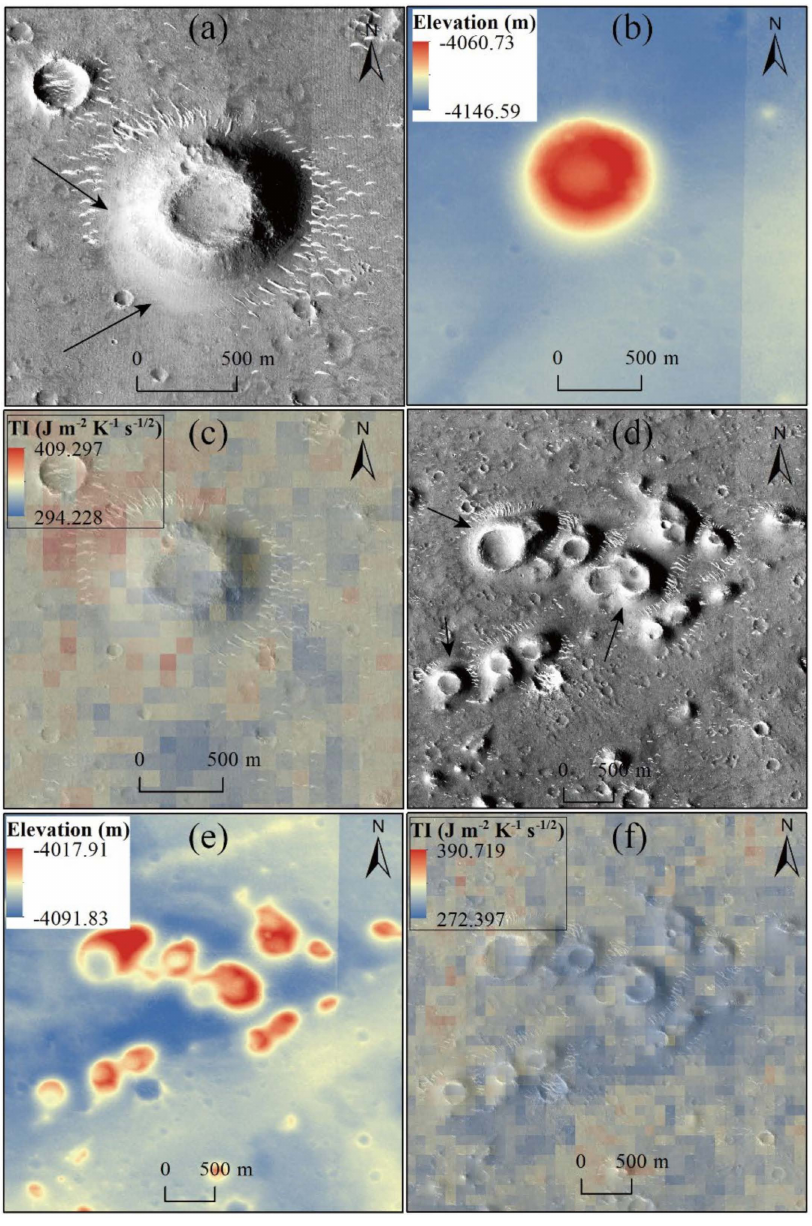
Figure 6. Examples of the landing area cones. ( a , d ) are the HiRIC DOM images, ( b , e ) are the corresponding HiRIC DEM data, and ( c , f ) are the THEMIS − derived TI maps overlaying the panels ( a , d ), respectively. Black arrows denote the smooth and fine distinct materials associated with cones compared to the surrounding